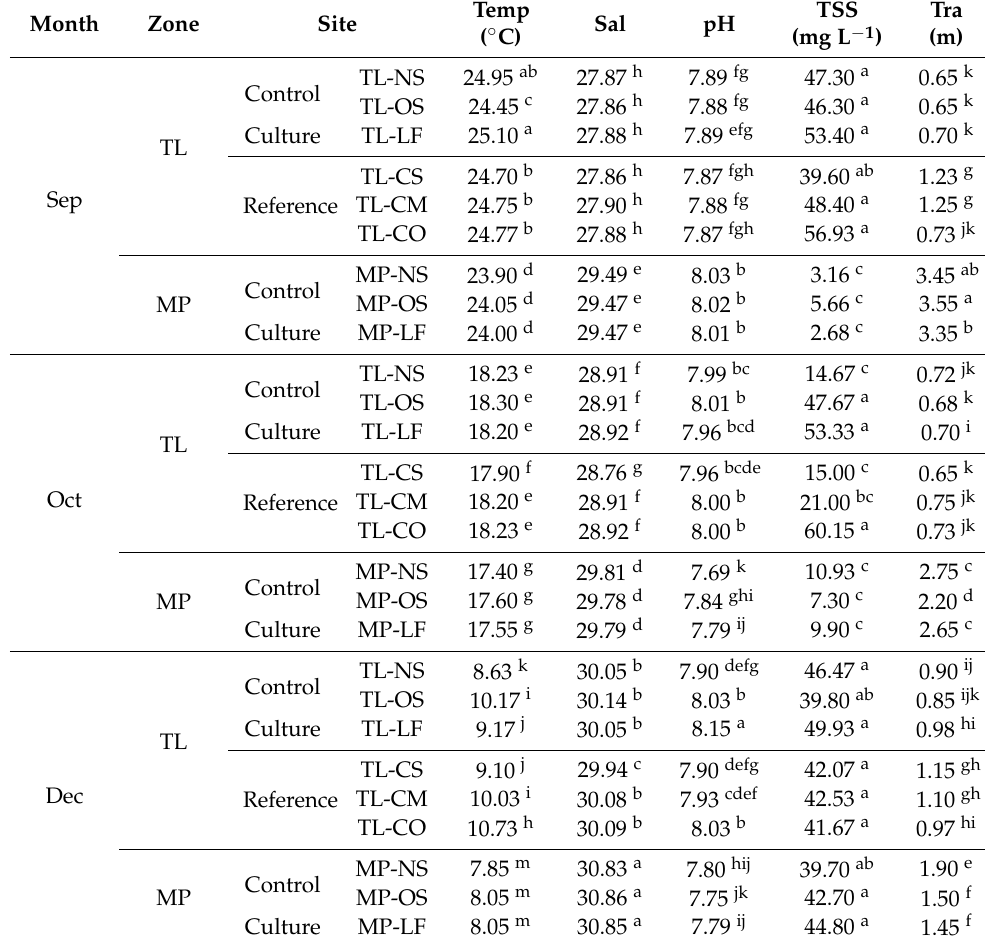
Table 1. The values of hydrographic parameters for the water samples collected from nine sites in or around two laver farms in Shandong Province, China in September (Sep), October (Oct), and December (Dec) 2019. The abbreviations of the sites are the same in Figure 1. The different superscript letters in each column shows that the values are significantly different ( p < 0.05). MP: Muping